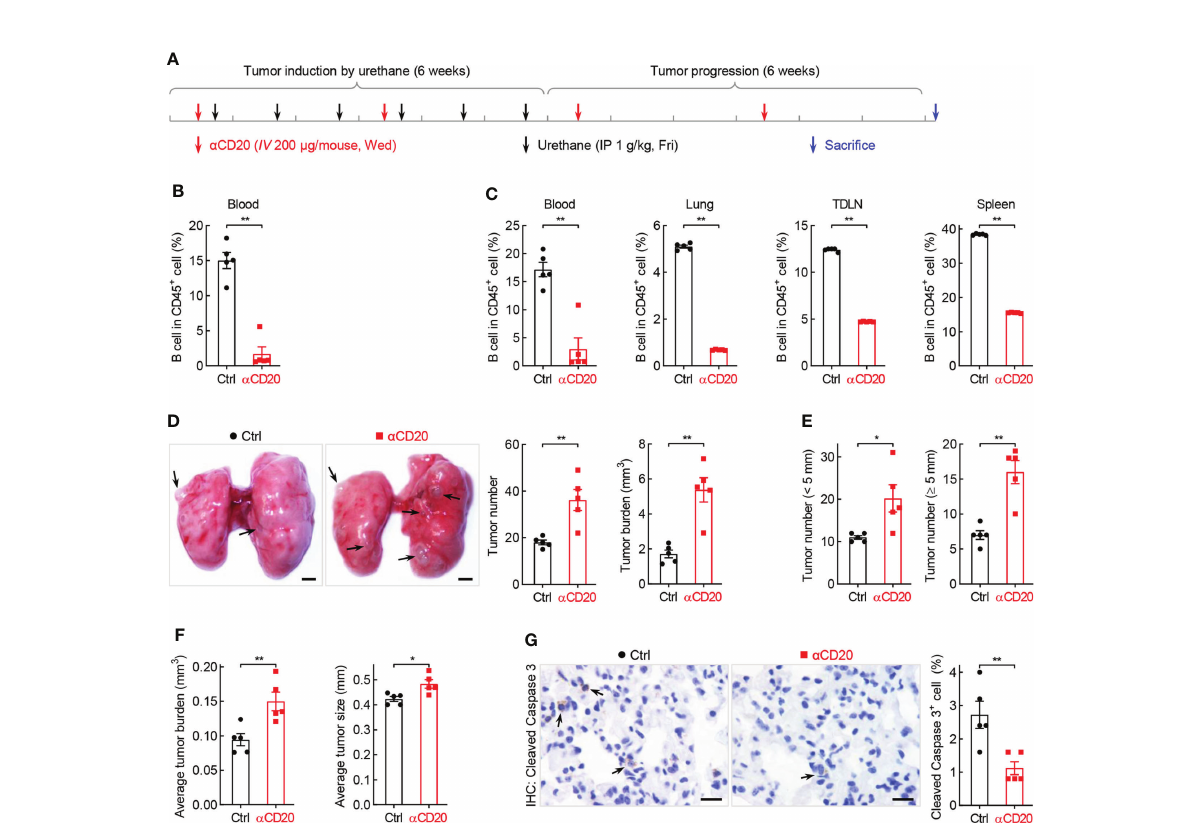
FIGURE 3 B cell depletion leads to increased lung tumorigenesis. (A) Schematic of B cell depletion by a CD20 in smoking carcinogen urethane-induced endogenous lung tumor model. (B) FACS data showing B cell depletion by a CD20 in blood before fi rst dose of urethane (n = 5). (C) FACS data showing B cell depletion by a CD20 in blood, lung, tumor-draining lymph node (TDLN), and spleen at the endpoint (n = 5). (D) Tumor examination showing increased lung tumor number and tumor burden by a CD20-mediated B cell depletion (n = 5). (E) Tumor examination showing elevated both small and large lung tumor numbers by a CD20-mediated B cell depletion (n = 5). (F) Tumor examination showing enlarged individual lung tumor by a CD20-mediated B cell depletion (n = 5). (G) IHC analysis showing decreased tumor cell apoptosis in mice with a CD20-mediated B cell depletion (n = 5). TDLN: mediastinum lymph node. Data shown were representative of two independent experiments with similar results. Scale bar: 1 mm (D) and 20 µm (G) . Student ’ s t test (two tailed, unpaired) was performed (B - G) . Data represented means ± SEM (B - G) . * p < 0.05; ** p